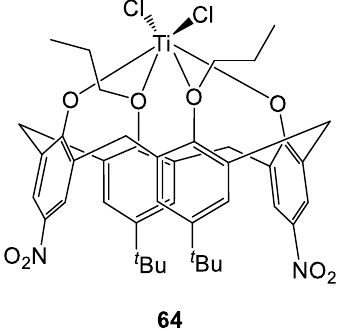
Figure 15. Titanocalix[4]arenes 64 tested in the ROP of L - lactide [30].